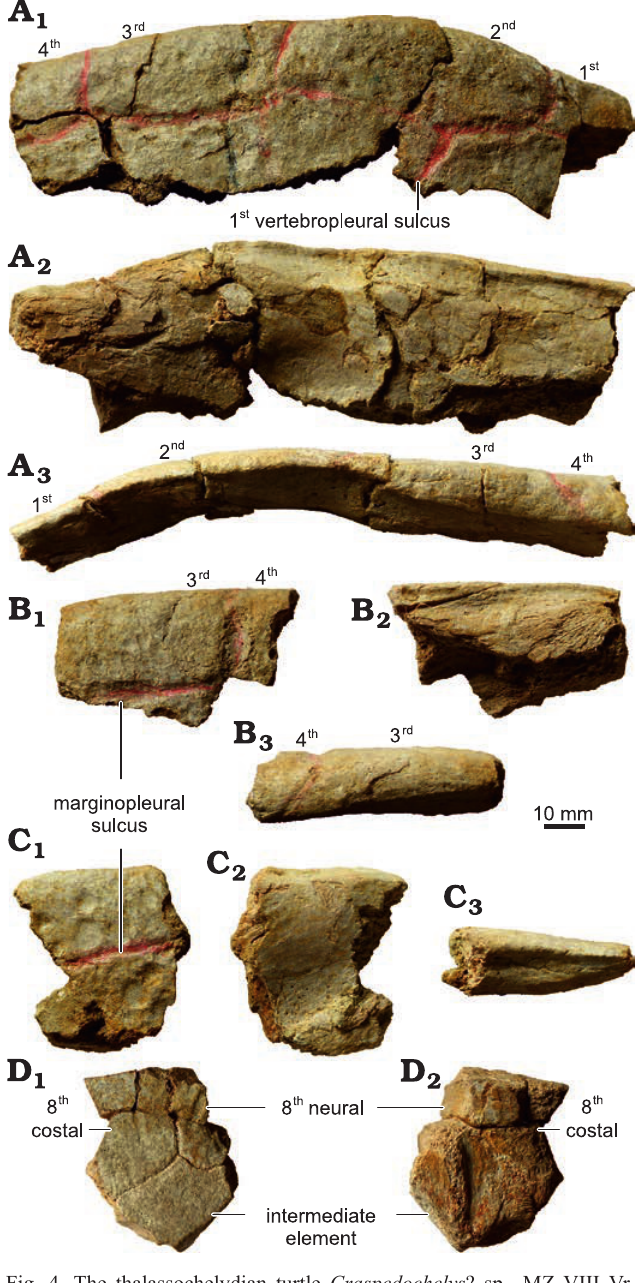
Fig. 4. The thalassochelydian turtle Craspedochelys ? sp., MZ VIII Vr- 71, from the Kimmeridgian of Krzyżanowice. A . Anterior left part of the carapacial rim (Fig. 6A: 4) in external (A 1 ), visceral (A 2 ), and peripheral (A 3 ) views. B . Fragment of the anterior right part of the carapacial rim (Fig. 6A: 5) in external (B 1 ), visceral (B 2 ), and peripheral (B 3 ) views. C . Unidentified part of the carapacial rim in external (C 1 ), visceral (C 2 ), and peripheral (C 3 ) views. D . Fragment of the posterior part of the cara- pace (Fig. 6A: 6). A–C likely belong to the same individual as the material shown in Fig. 3. The numbers indicate marginal